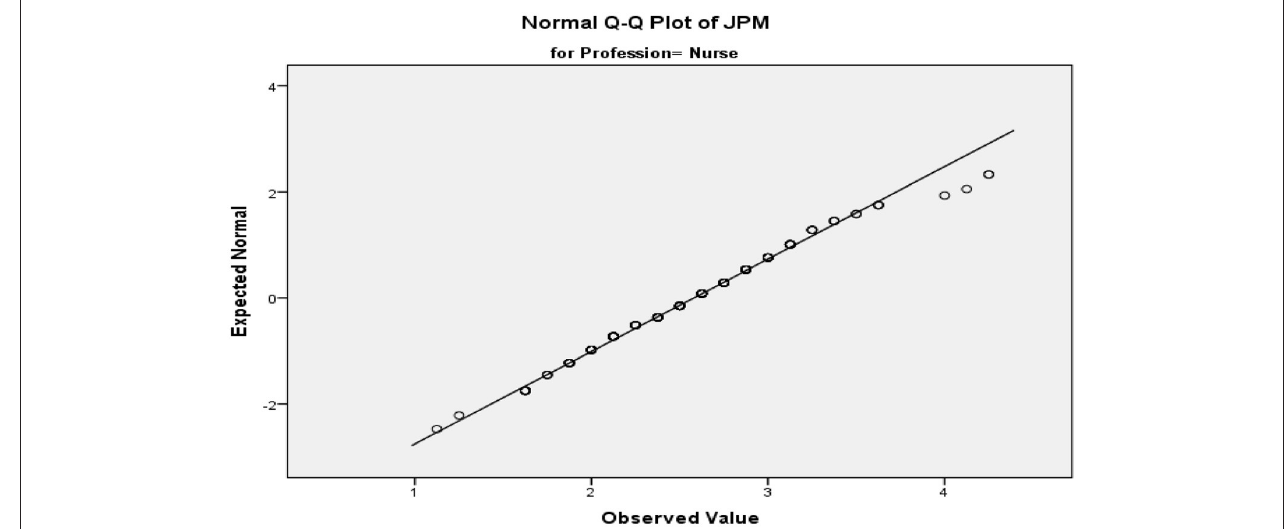
FIGURE 2 | Normality plot of JPM.